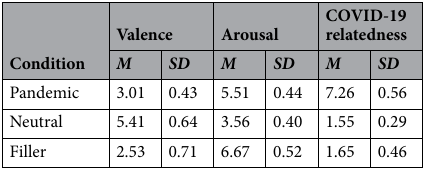
Table 1. Stimuli characteristics for each